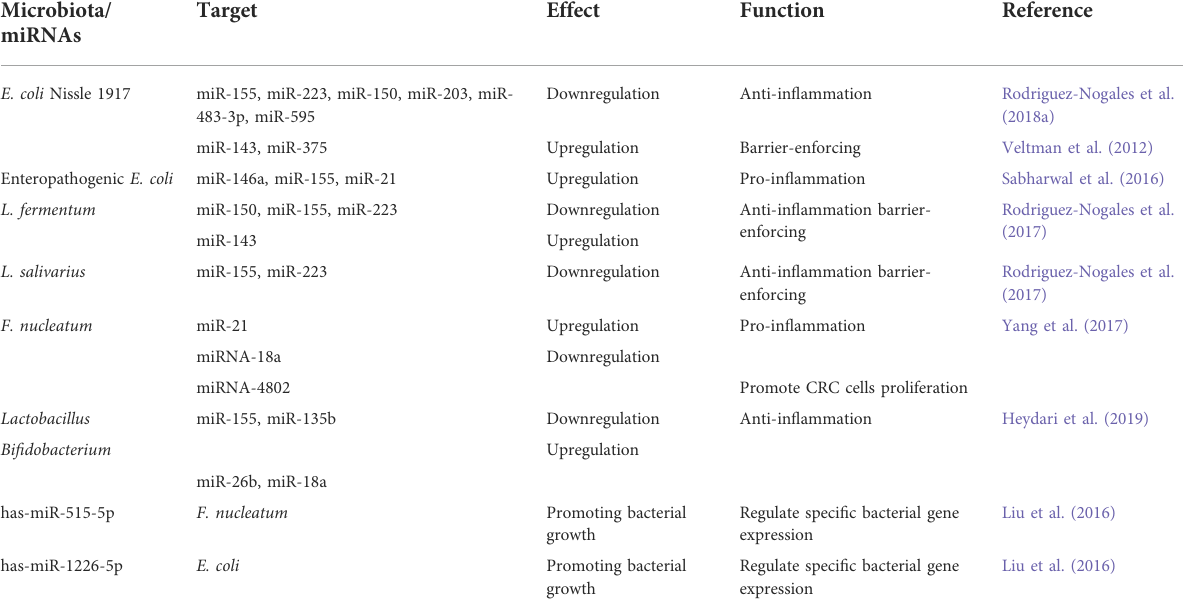
TABLE 5 MicroRNA-microbiota interaction in host